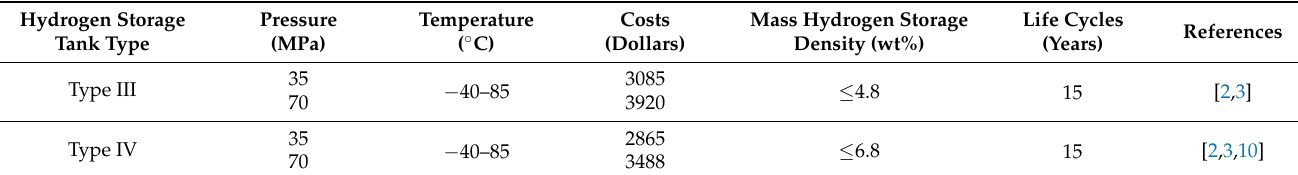
Table 1. Comparisons between two kinds of compressed hydrogen storage